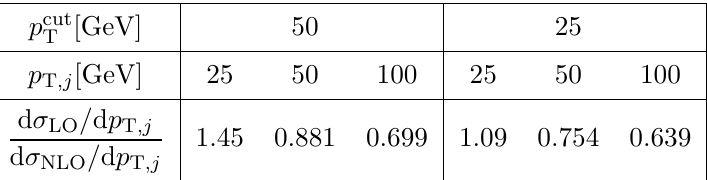
Table 6. Comparison of the LO and NLO distributions in the leading-jet p and 25 GeV. The results correspond to the ttbbj phase space with the cut p T > p cut b -jets. The reported values at p T ;j = GeV = 25 ; 50 ; 100 correspond to the bins [22 : 4 ; 26 : 0], [47 : 3 ; 55 : 0] and [86 : 0 ; 100].